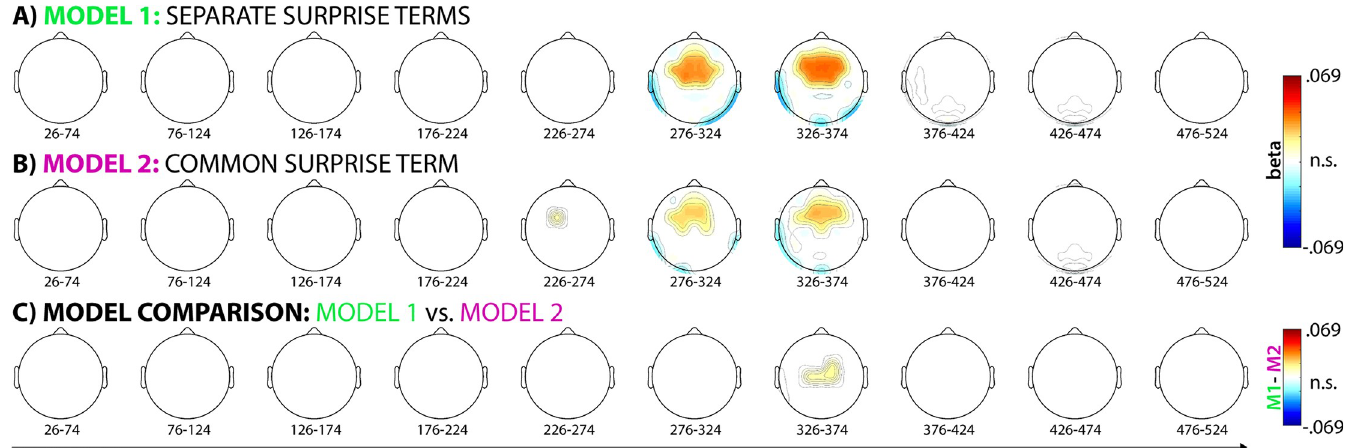
Fig 4. Results from the whole-brain single-trial model fitting analysis described in Fig 2. Each topography depicts the averaged standardized beta coefficient at each channel in the respective time window (x-axis) and model (plots A and B), as well as the M1-M2 model comparison (plot C). White areas denote channels at which the fit within the depicted time-window was non-significant (p < .00044). In A and B, red areas denote significant positive correlations between the respective model and the EEG data, blue areas denote significant negative correlations. In C, red areas denote higher correlations between Model 1 and the data compared to Model 2.